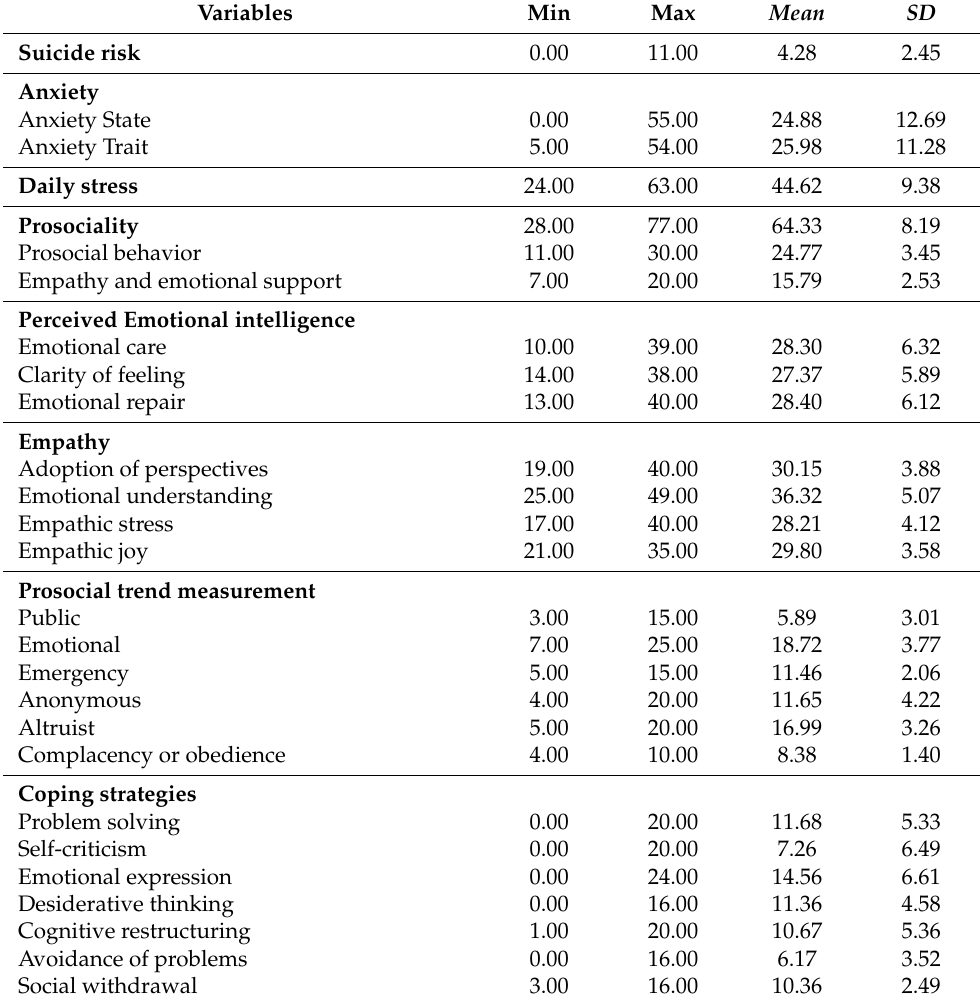
Table 1. Descriptive statistics of suicidal risk, anxiety, daily stress, prosociality, perceived emotional intelligence, empathy, measures of prosocial tendency, and coping